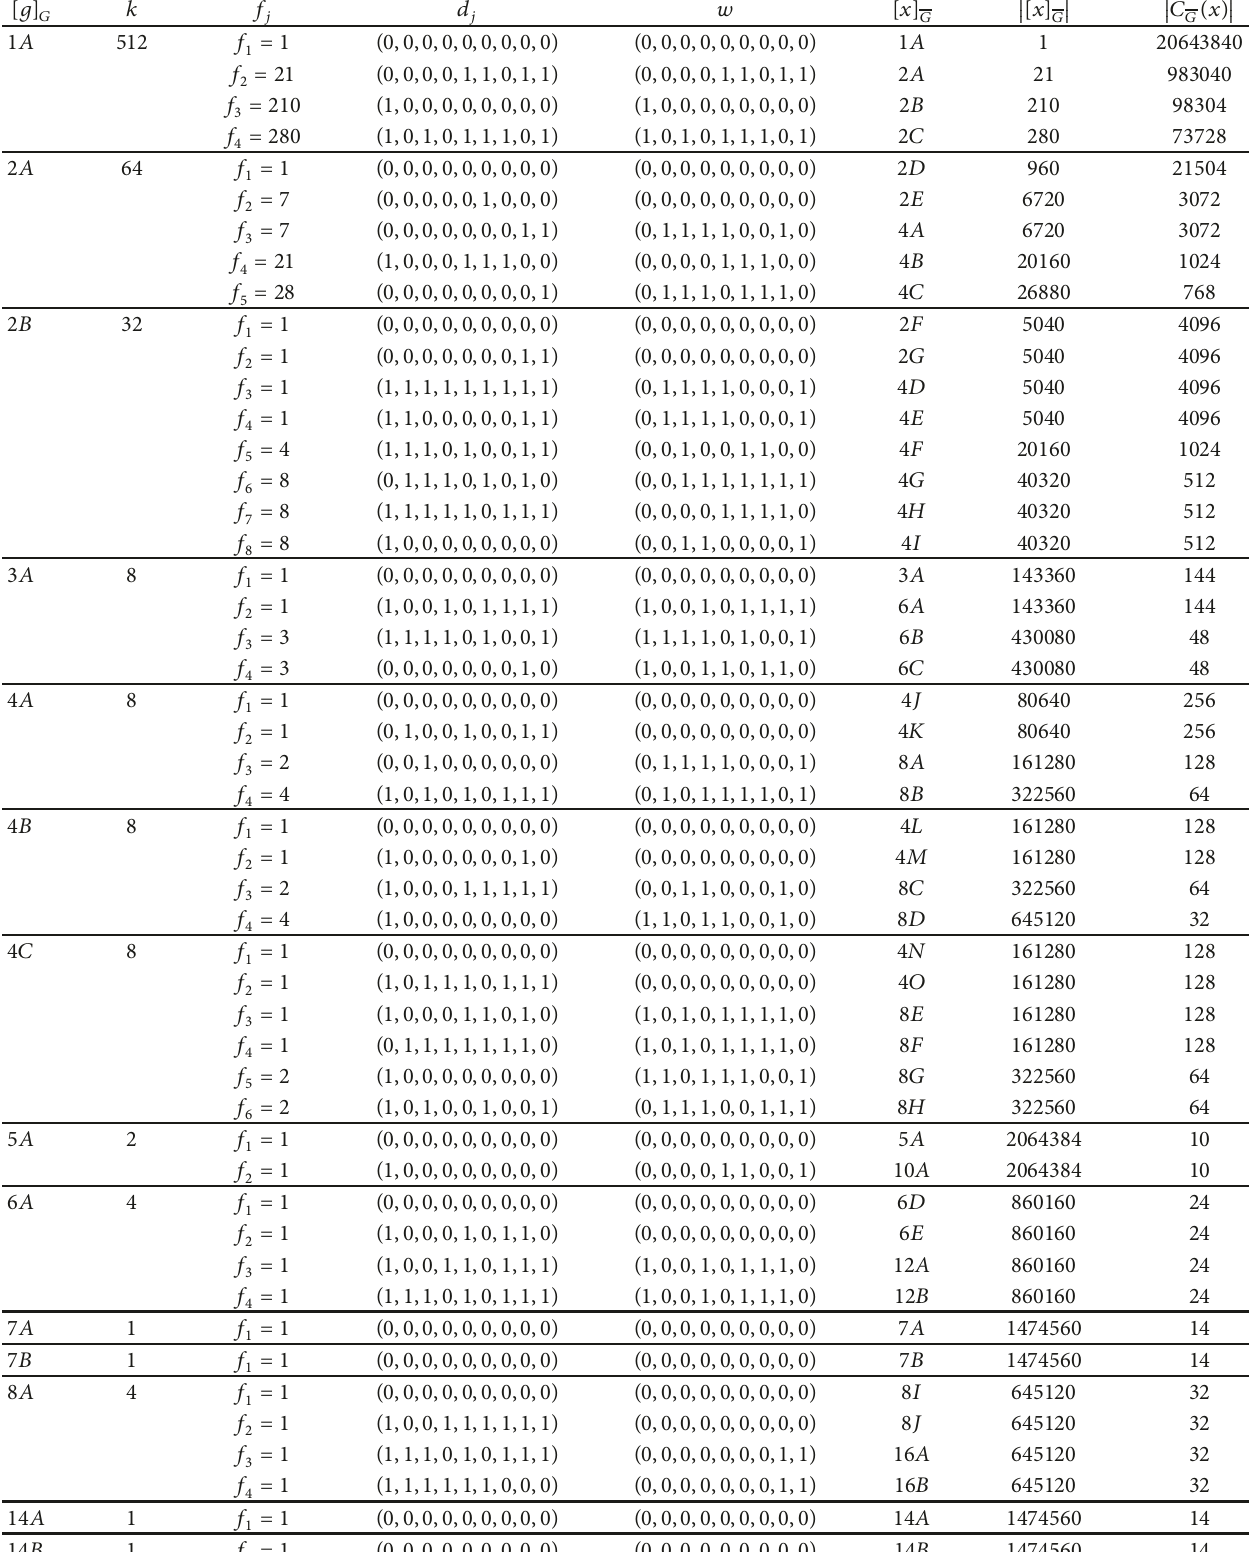
Table 2: The conjugacy classes of elements of 𝐺 = 2 9 : (𝐿 3 (4) : 2)